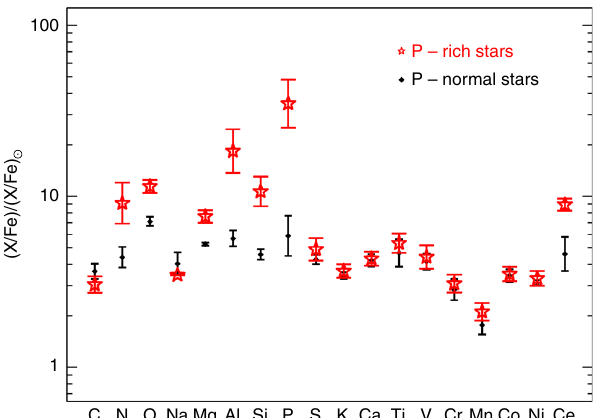
Fig. 4 Chemical abundance pattern observed in P-rich stars. Red and black symbols correspond to the median chemical abundances of the P-rich and P-normal (twin) stars, respectively. Error bars show the star-to-star abundance rms scatter. Note that only stars without upper limits are considered in the computation of the median values. The P-rich stars show clear enhancements of O, Mg, Al, Si, P and Ce compared to their normal (twin)